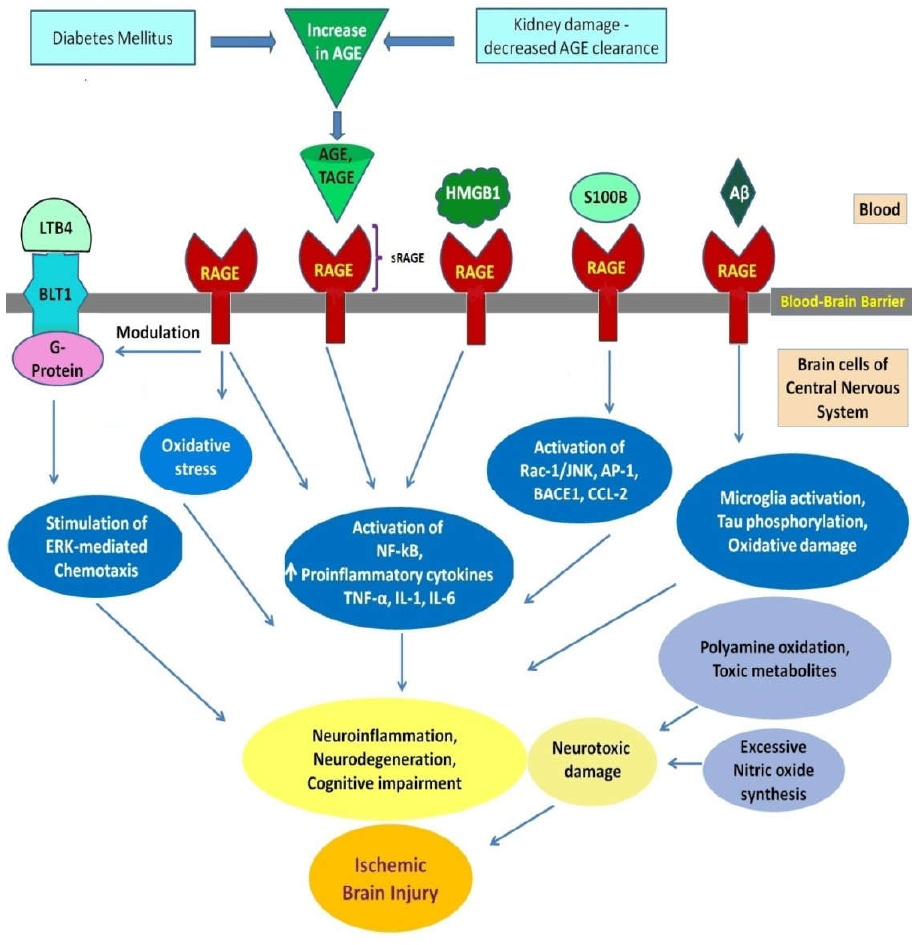
Figure 1. AGE–RAGE, G-protein coupled Leukotriene B4 receptor BLT-mediated molecular and pathological mechanisms in neurons, astrocytes, microglia, endothelial cells, and blood–brain bar- rier of central nervous system in diabetic ischemic stroke: (1) Modulation of G protein-coupled Leukotriene B4 (LTB4) receptor BLT1 by RAGE. (2) Binding of AGE to RAGE. sRAGE, Soluble RAGE—the extracellular/cytosolic domain of RAGE. (3) Binding of RAGE with ligands: AGE/TAGE, Advanced Glycation End Product/Toxic Advanced Glycation End Product; extracel- lular HMGB1, High-Mobility Group Box 1 protein released from necrotic cells; S100B protein from S100/Calgranulin family of proteins; A β, Amyloid beta peptides . (4) Molecular, pathological mecha- nisms involving ERK, theExtracellular-Signal-Regulated Kinase; NF-κB, Nuclear factor kappa- light-chain-enhancer; TNF-α, Tumor Necrosis Factor-α; IL-1, IL- 6, Interleukins 1,6; Rac-1/JNK, Rac-1 G protein/Jun N-terminal kinase; BACE1, Beta-site APP Cleaving Enzyme 1; AP-1, Activa- tion Protein 1 and CCL2, Chemokine (C-C motif) ligand 2.